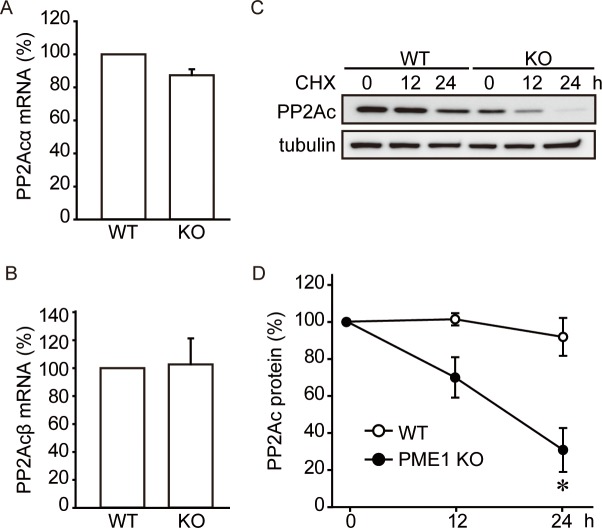
PME-1 protects PP2Ac from protein degradation.(A-B) Loss of PME-1 does not affect PP2Ac mRNA expression. mRNA levels of PP2Ac α (A) and β (B) isoforms were analyzed by real-time qPCR. Quantitative data from 2 independent experiments performed in duplicate are shown. (C-D) PME-1 protects PP2Ac from protein degradation. PP2Ac degradation was analyzed by cycloheximide chase assay. Representative images (C) and quantitative data for PP2Ac protein level (D) from 5 independent experiments are shown. *: P<0.05 vs. WT.